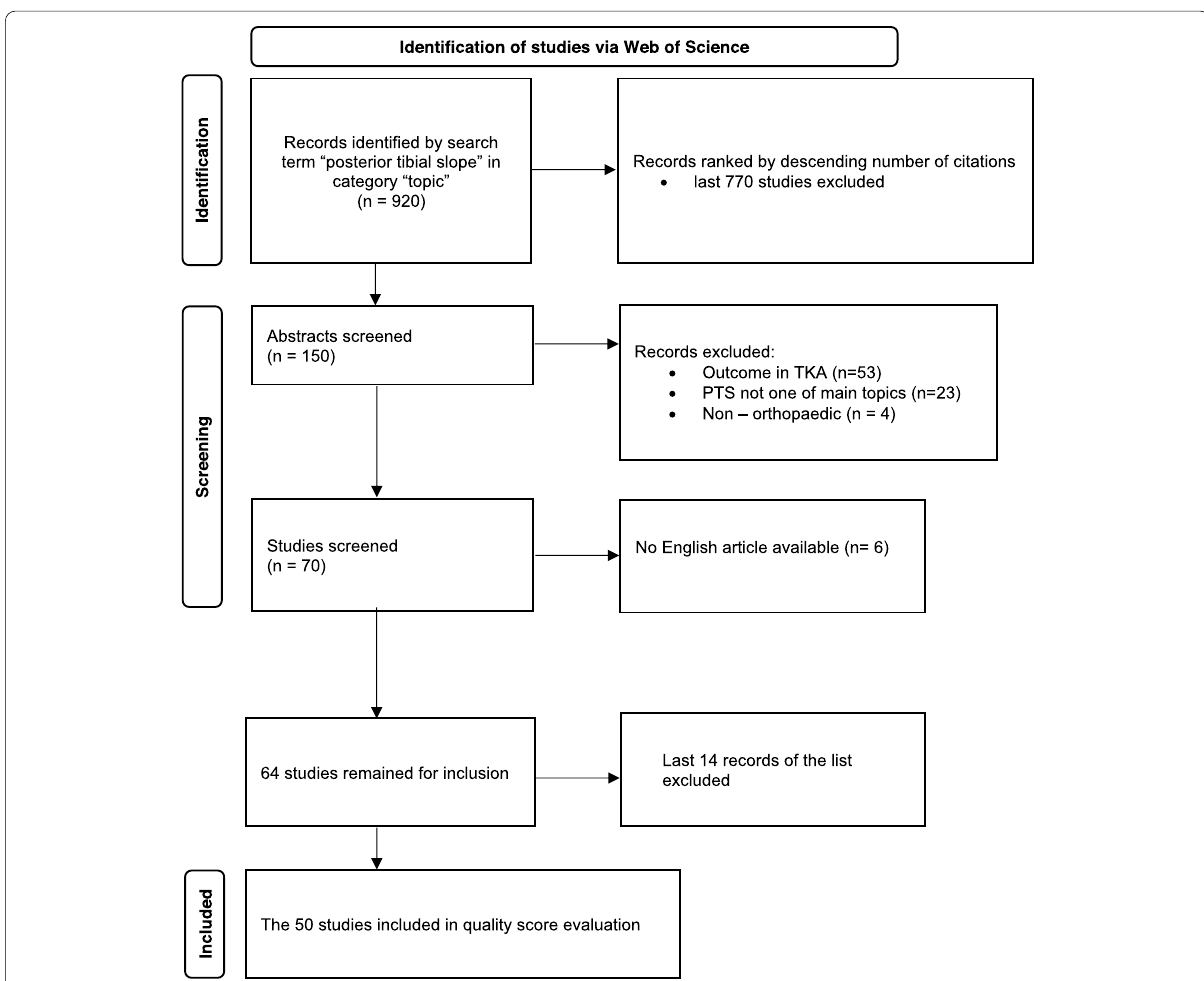
Fig. 1 PRISMA flowchart demonstrating the article selection process. Posterior Tibial slope (PTS), Total Knee Arthroplasty